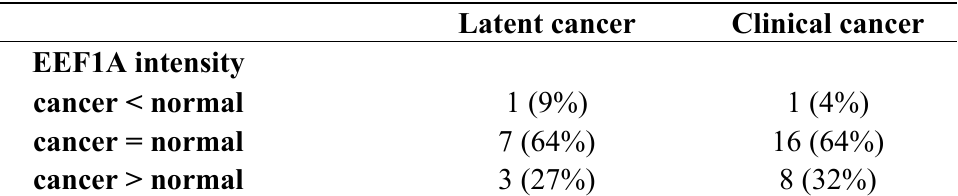
Table 4. Intensity of EEF1A in prostate cancer.